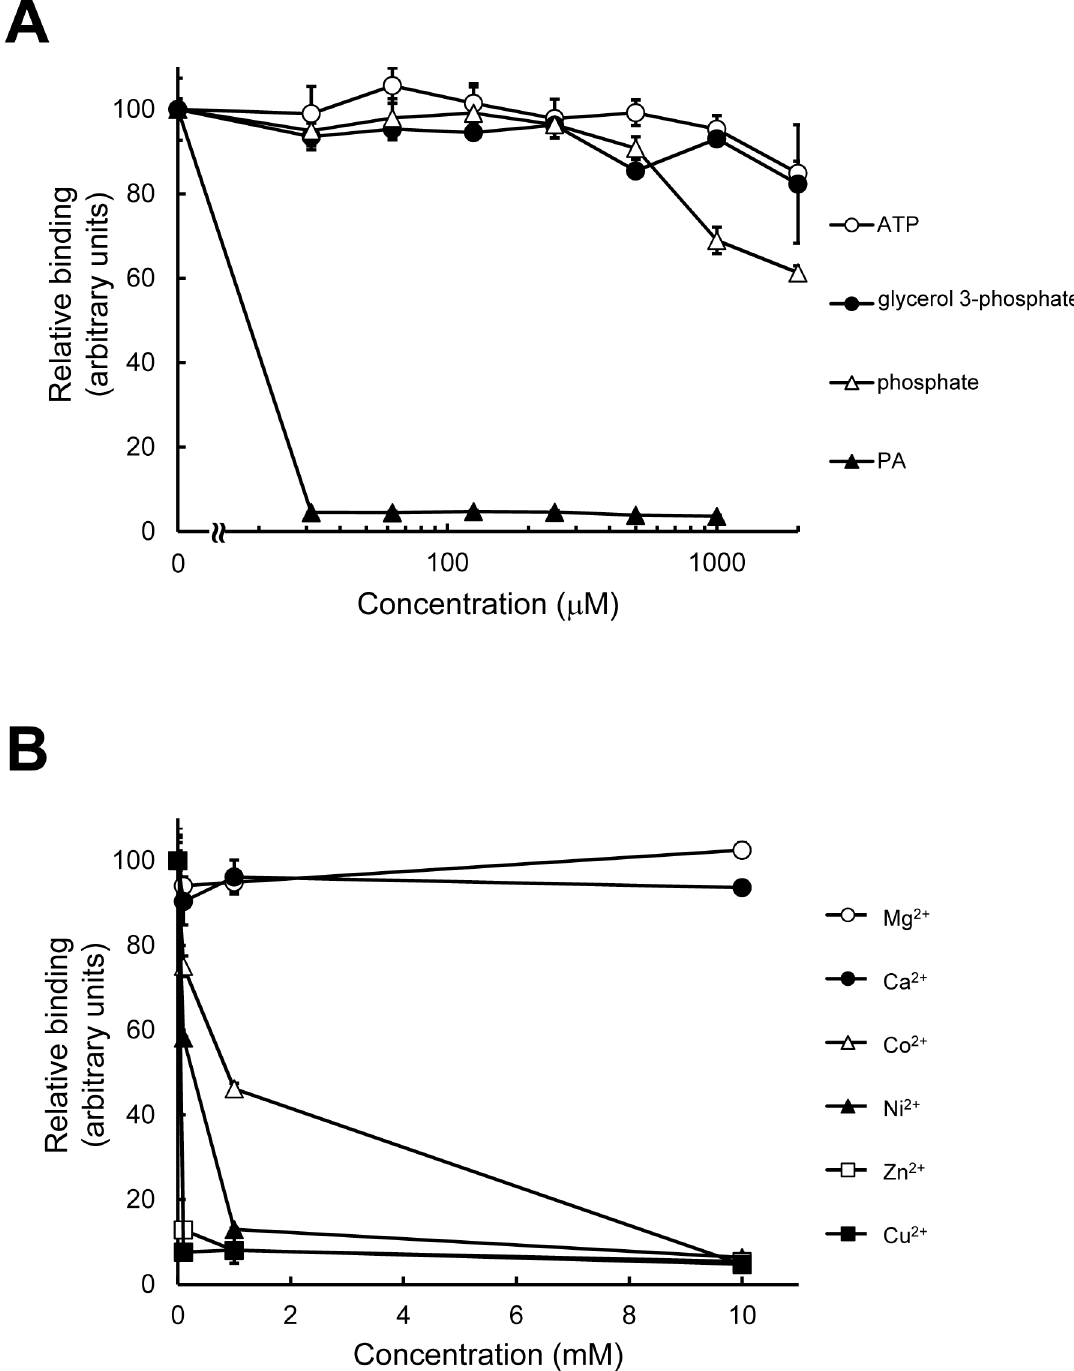
Fig 4. Inhibitory effect of soluble head groups and divalent cations on binding of PAB-TP to vesicles containing PA. (A) Binding of PAB-TP to LUVs (31.25 μ M total lipids) composed of DOPA/DOPC/biotin-DOPE/cholesterol (10:58:2:30) in the presence of indicated concentrations of ATP, glycerol 3-phosphate, phosphate, and LUVs composed of DOPA was examined by the SPVB assay. (mean ± SE, n = 3). (B) PAB-TP coated on the solid phase was incubated with MgCl 2 , CaCl 2 , CoCl 2 , NiCl 2 , ZnCl 2 , and CuCl 2 (0.1, 1, 10 mM). After removal of unbound divalent cations, binding of PAB-TP to LUVs (31.25 μ M total lipids) composed of DOPA/DOPC/biotin-DOPE/cholesterol (10:58:2:30) was examined by the SPVB assay. (mean ± SE, n = 3). The binding of LUVs to PAB-TP in the absence of competitor (A) or divalent cation (B) was represented as 100 (arbitrary units).